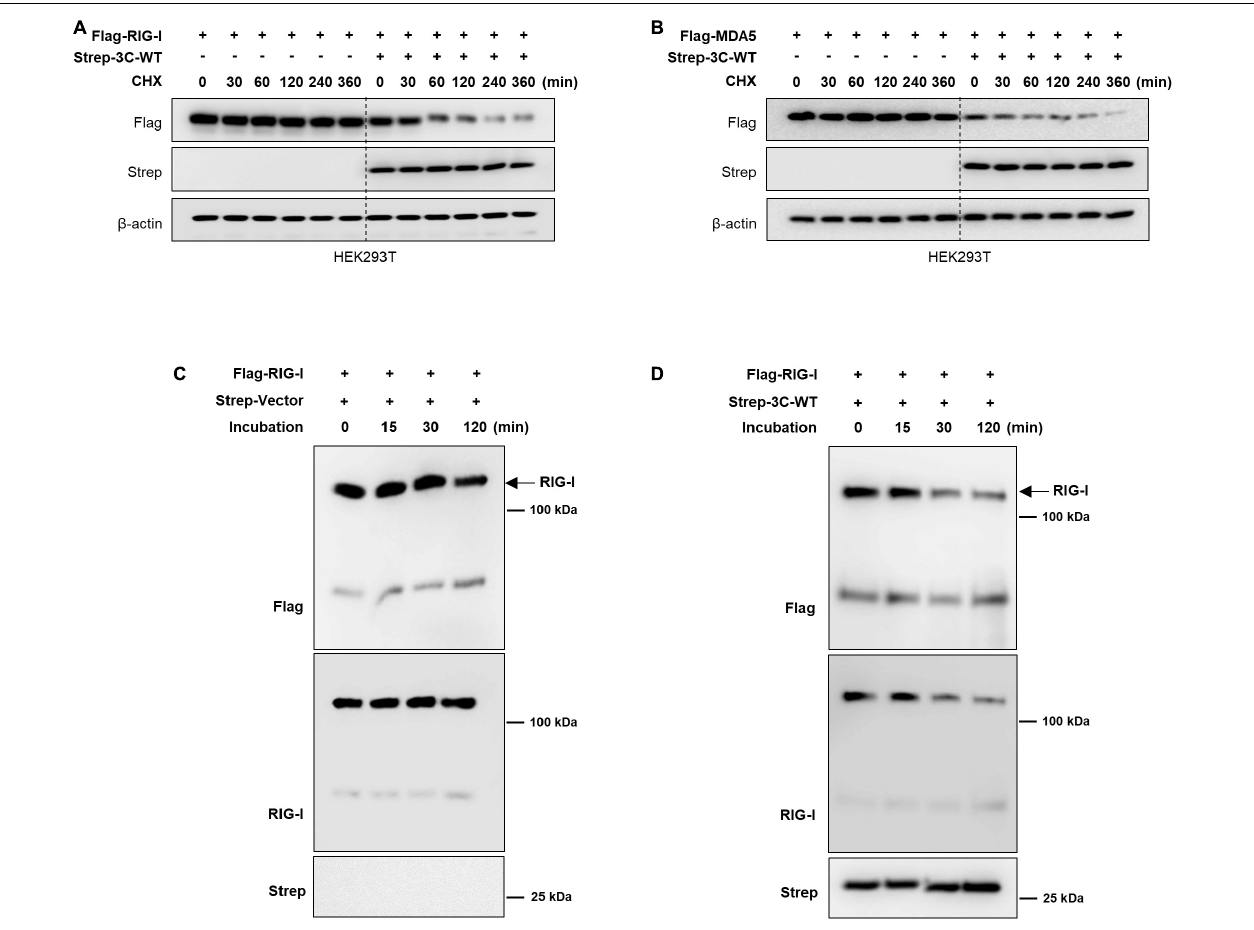
FIGURE 3 | Wild-type FMDV 3C pro mediated RIG-I and MDA5 degradation is related to its protease activity. HEK293T cells were transiently transfected with (A) Flag-tagged RIG-I or (B) MDA5 plasmid together with Strep-tagged control plasmid or Strep-tagged wild-type FMDV 3C pro . At 24 h after transfection of plasmids, cells were treated with Cycloheximide (CHX) and cells were harvested at indicated time points after CHX treatment. Cell lysates were subjected to immunoblotting with individual antibodies against Flag, Strep, and β -actin. For the wild-type FMDV 3C pro mediated in vitro RIG-I degradation, RIG-I protein (2 µ g) was incubated with (C) control or (D) with FMDV-3C wild-type protein (2 µ g) in the in vitro degradation buffer containing 50 mM HEPES-KOH pH 7.5, 35 mM KCl and 1 mM DTT. Reactions were carried out at 37 ◦ C for 0–2 h and terminated by adding an equal volume of SDS-PAGE sample buffer and heating at 100 ◦ C for 5 min. The samples were subjected to immunoblotting with anti-Flag, -RIG-I, and -Strep antibodies.